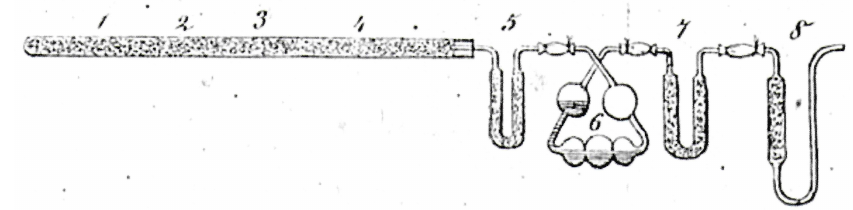
Figure 2. Original set-up developed by Jean-Baptiste Dumas.